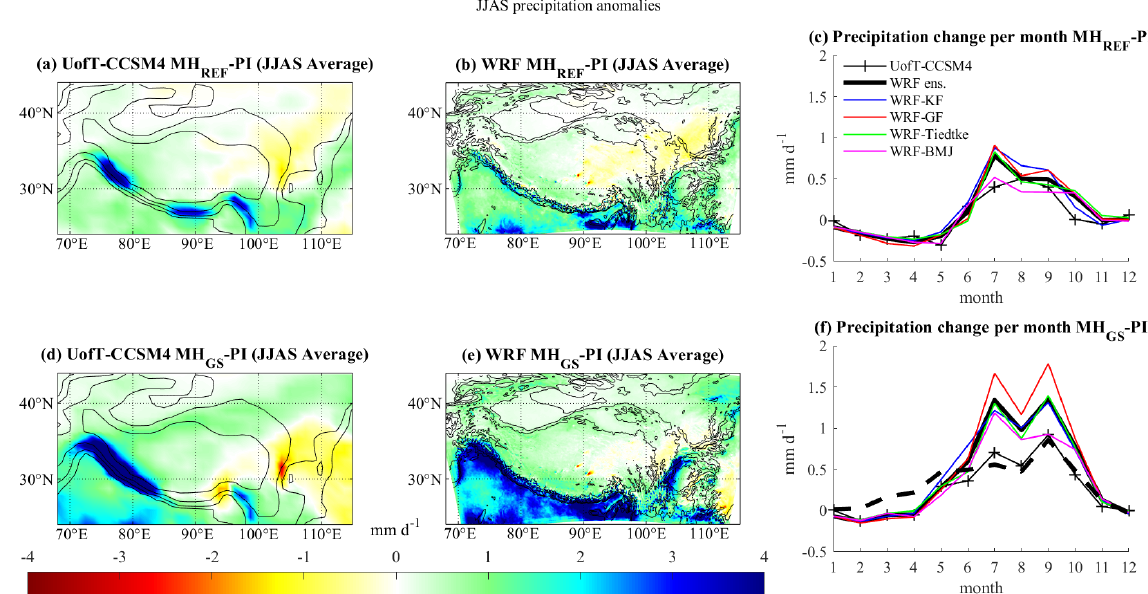
Figure 6. JJAS precipitation anomalies (mmd − 1 ) for (a, b) MH REF and (d, e) MH GS in (a, d) UofT-CCSM4 and the (b, e) WRF ensemble mean. Monthly precipitation anomalies (mmd − 1 ) in UofT-CCSM4 and four physics ensemble members for (c) MH REF and (d) MH GS . The dashed line in (f) represents the MH GS –MH REF anomalies in the WRF ensemble mean. The topography contours of 500, 1000, 2000, and 4000m are also shown in (a) , (b) , (d) and (e)